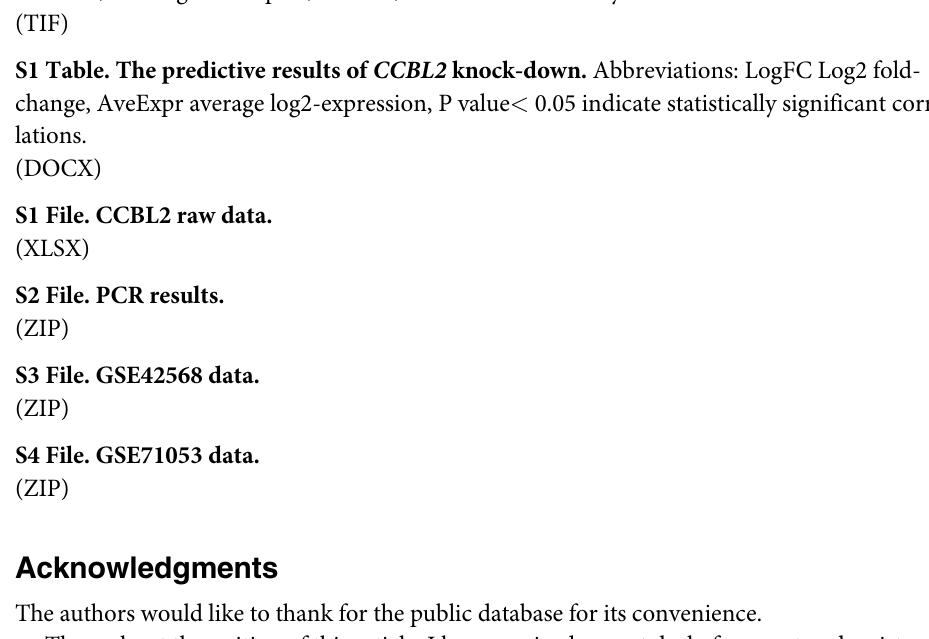
S1 Fig. Correlation analysis between CCBL2 and AR through TIMER databases. Abbrevia- tion: AR, Androgen Receptor; TIMER, Tumor Immunoassay Resource. S1 Table. The predictive results of CCBL2 knock-down. Abbreviations: LogFC Log2 fold- change, AveExpr average log2-expression, P value < 0.05 indicate statistically significant corre-